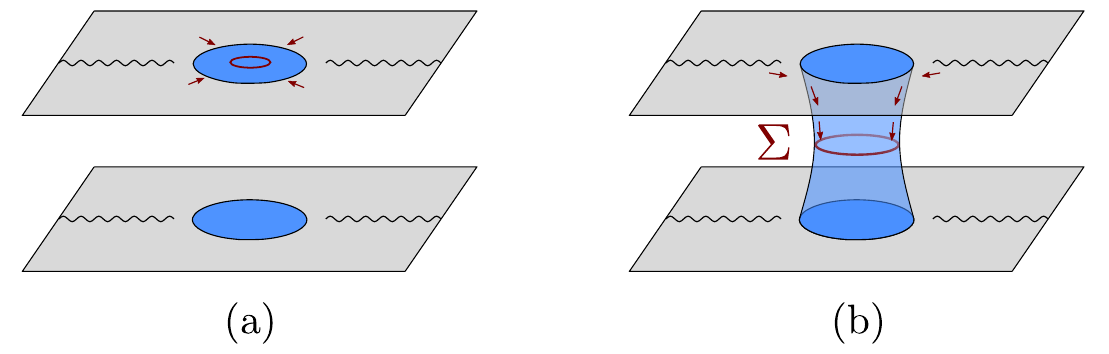
Figure 6 . (a) Without the replica wormhole, the topological operator can be shrunk to a point. (b) With the replica wormhole, we can deform the topological operator to surround the throat of the wormhole. Therefore the dependence on the parameter α diagnoses the charge flowing through the